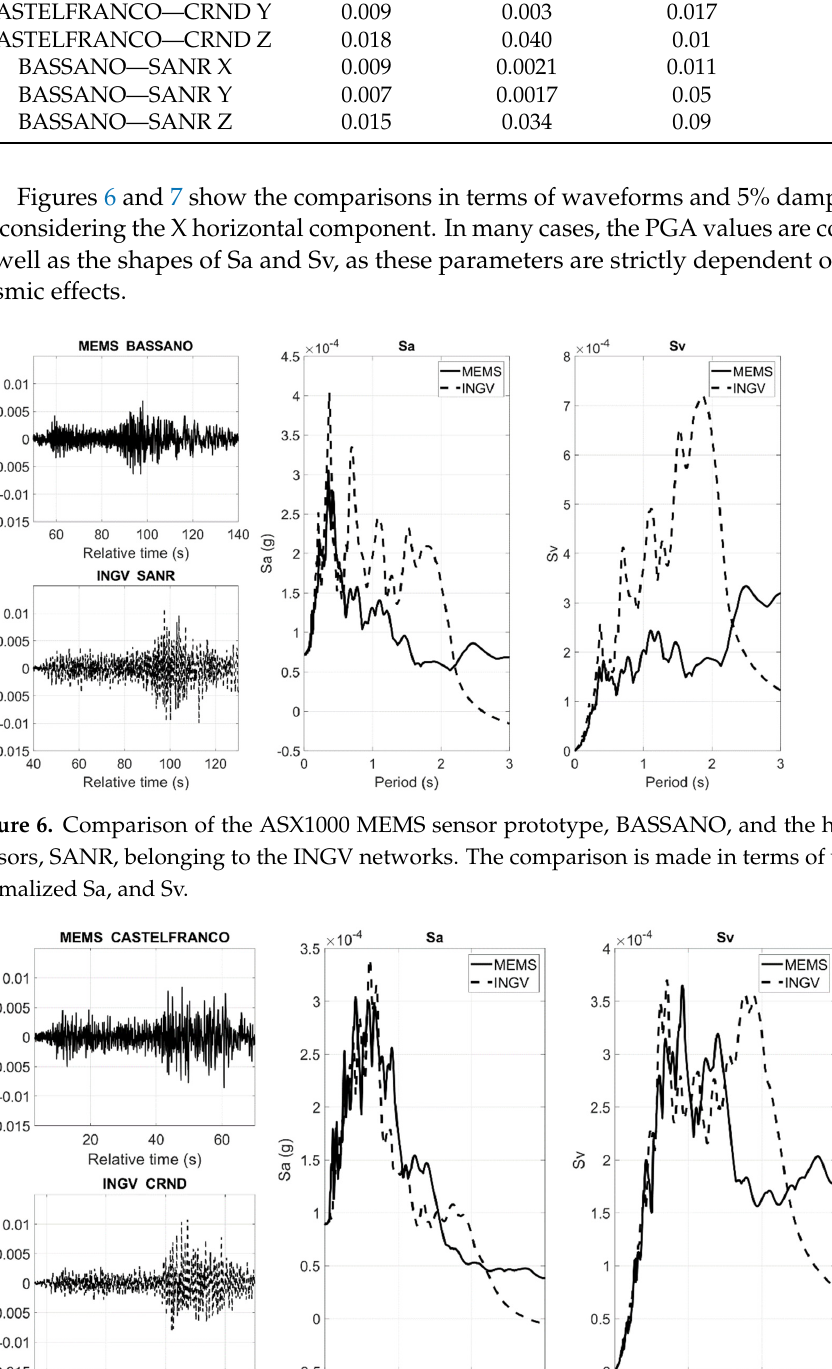
SENSOR—COMPONENT